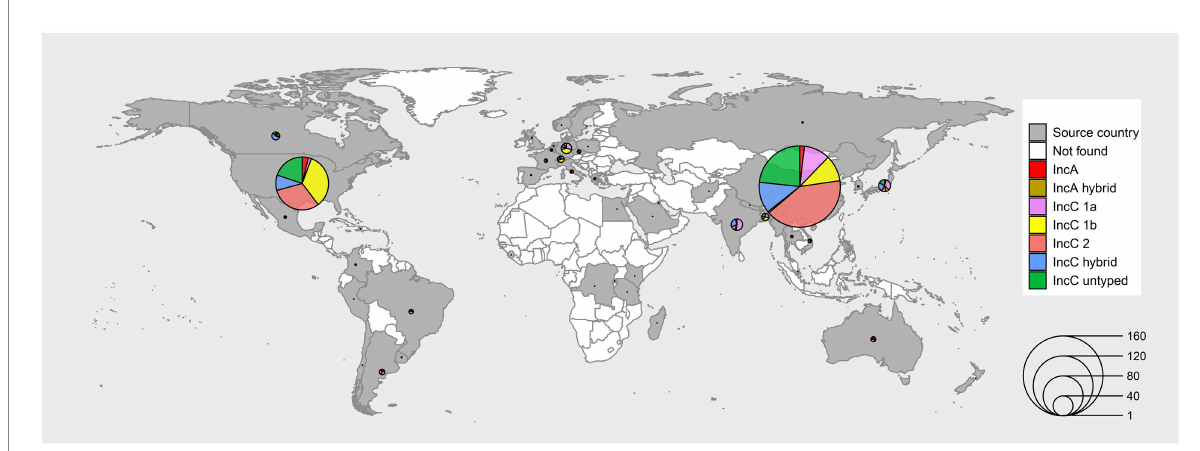
FIGURE 1 Sources and types of IncA and IncC plasmids in our dataset. The regions with grey colours represent that plasmids have been isolated, and white represents that no plasmid was isolated. The size of the circles in the map indicates the plasmid number. The pie charts with different colours show the proportion of types of plasmids isolated from different